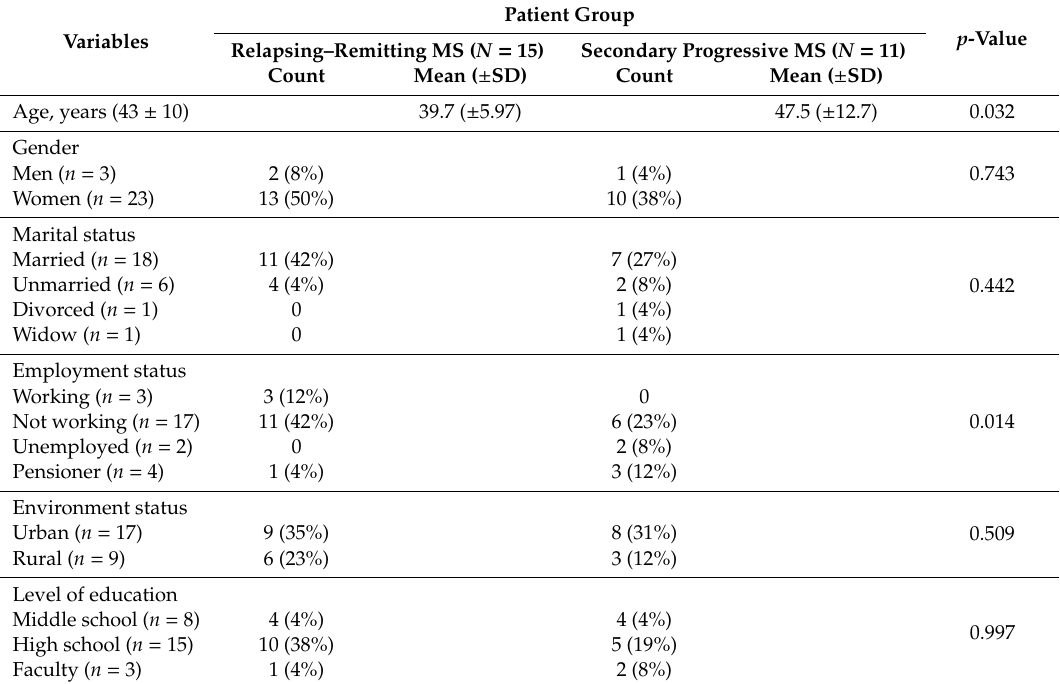
Table 1. Demographics of the multiple sclerosis (MS) patients examined in this study.